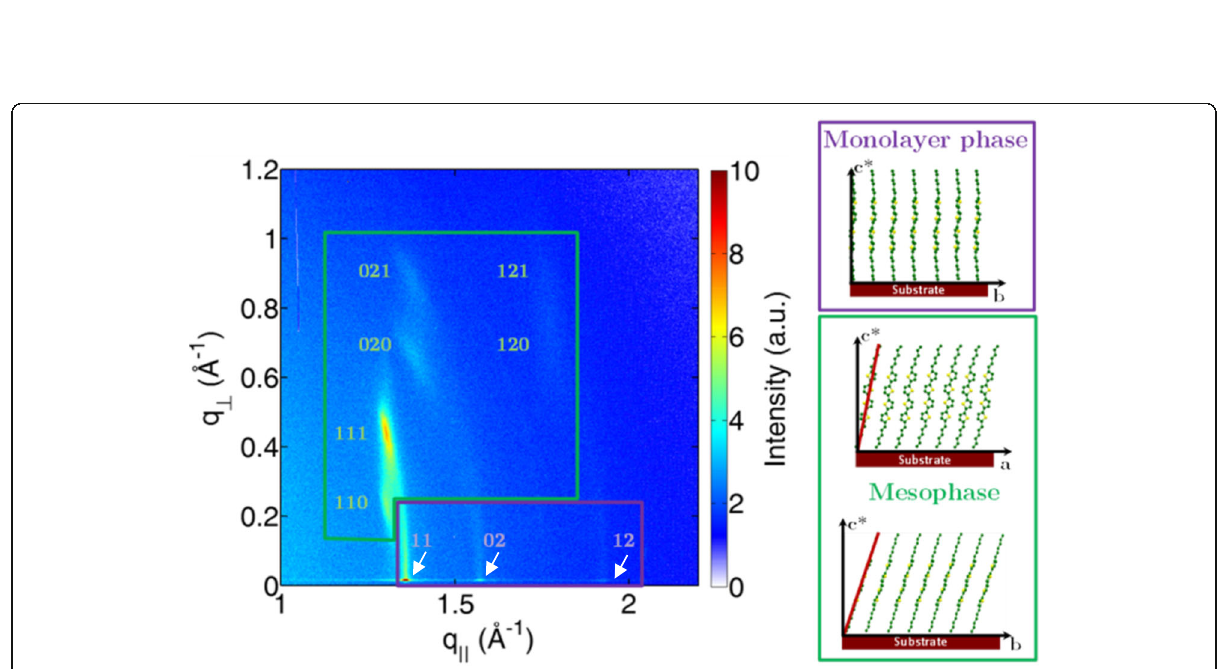
Fig. 4 2D-GIXD pattern of a DH4T film measured at 110